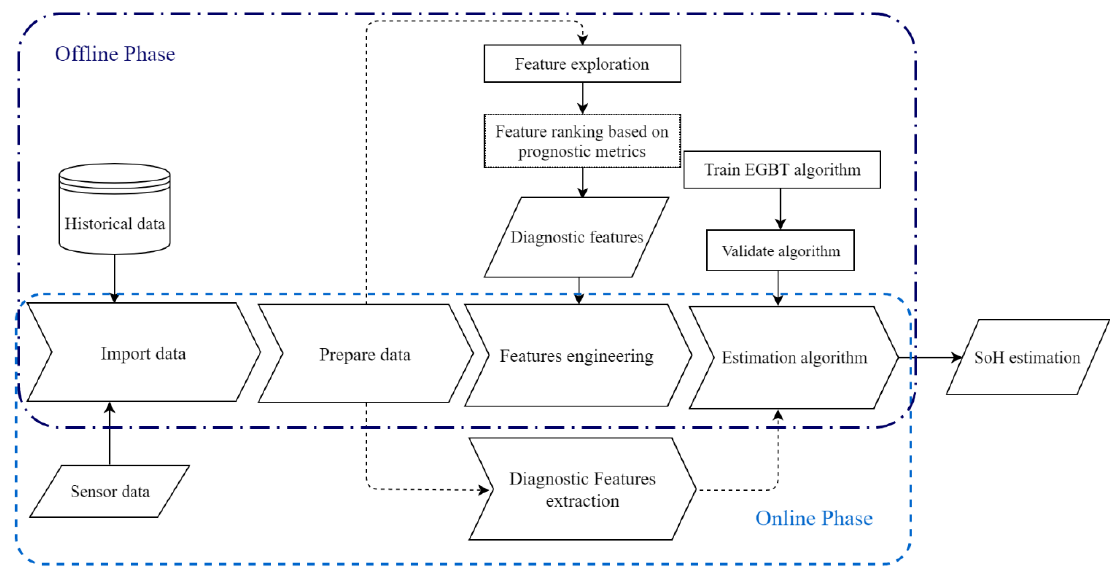
Figure 1. Framework of SoH estimation